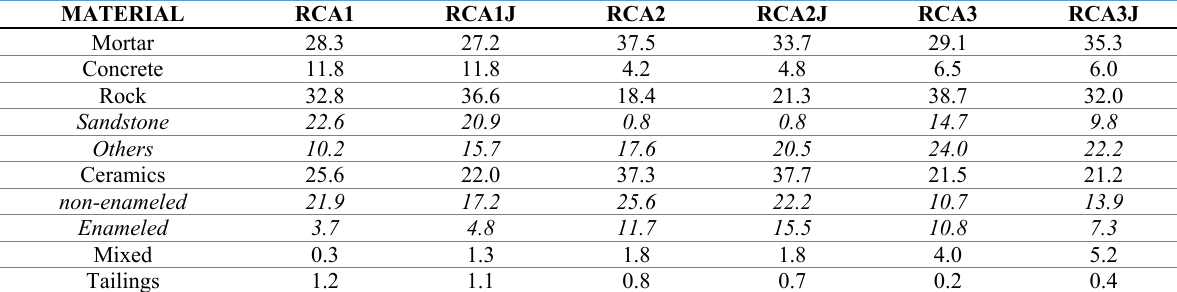
Table 4. Composition of the different materials obtained from the studied sources, before and after jigging, in percentage (%)